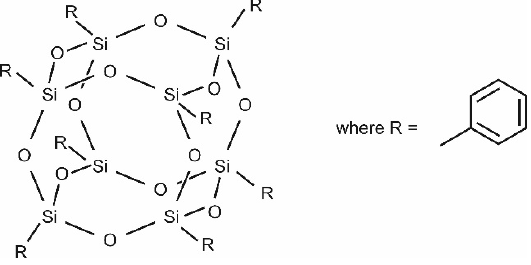
Figure 3. Chemical structure of POSS-Ph.